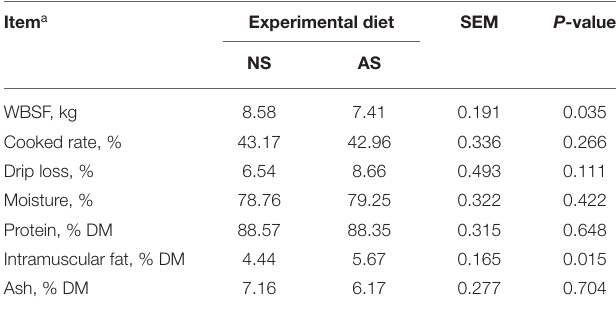
TABLE 6 | WBSF and chemical composition of steak samples of goats fed a total mixed ration supplemented with Napier grass silage (NS) or anthocyanin-rich black cane silage